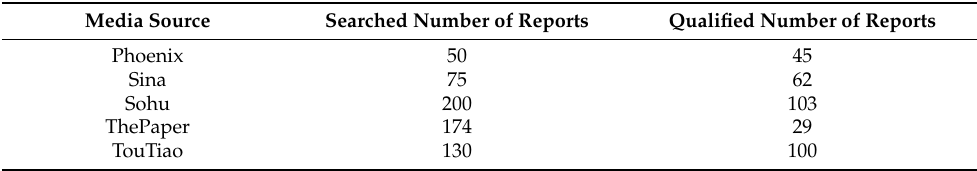
Table 3. Number of media reports on major